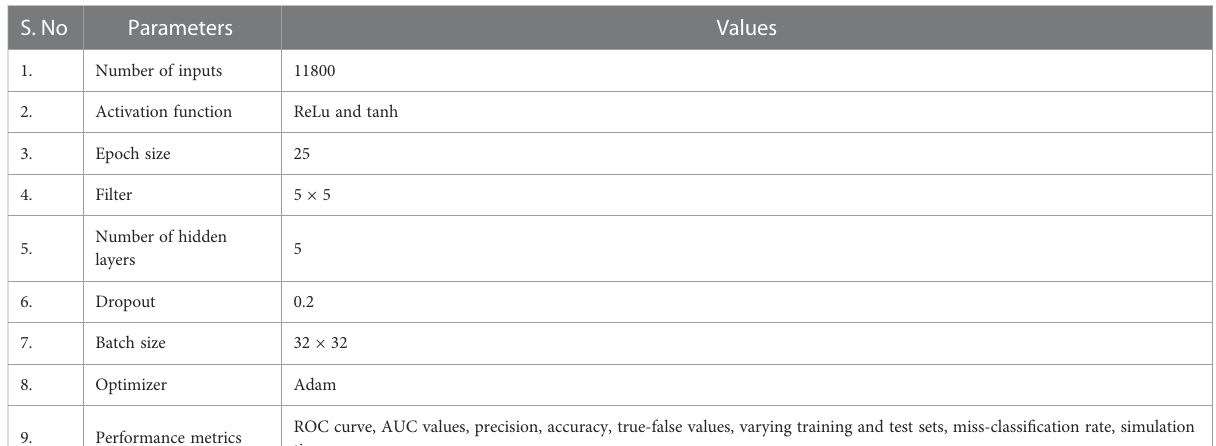
TABLE 2 Different parameters used for the validation and experimental work in the proposed research work.